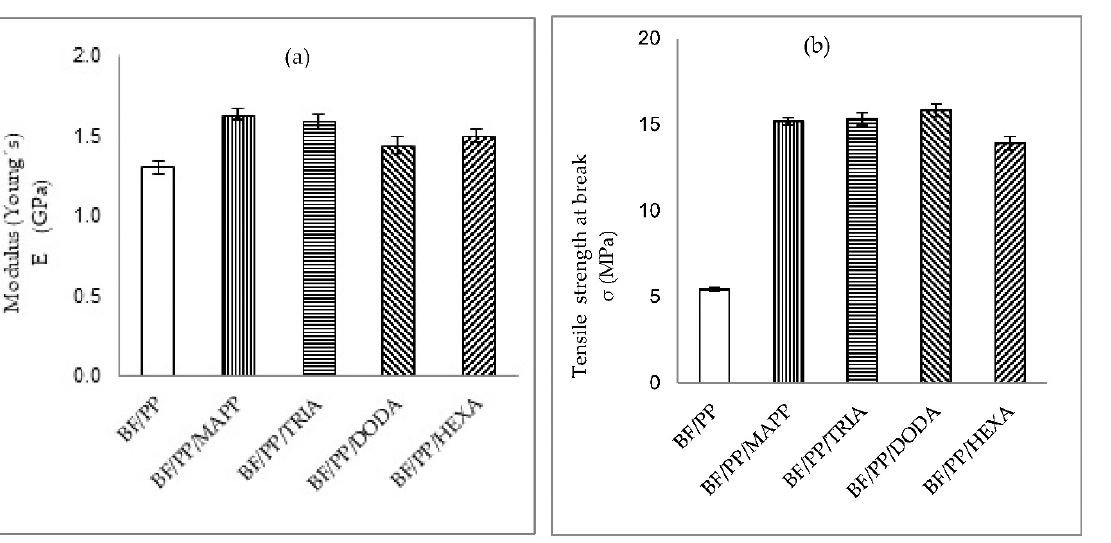
Figure 2. Results of the tensile test of the composites without and with CA: ( a ) Young’s modulus and ( b ) tensile strength at break.